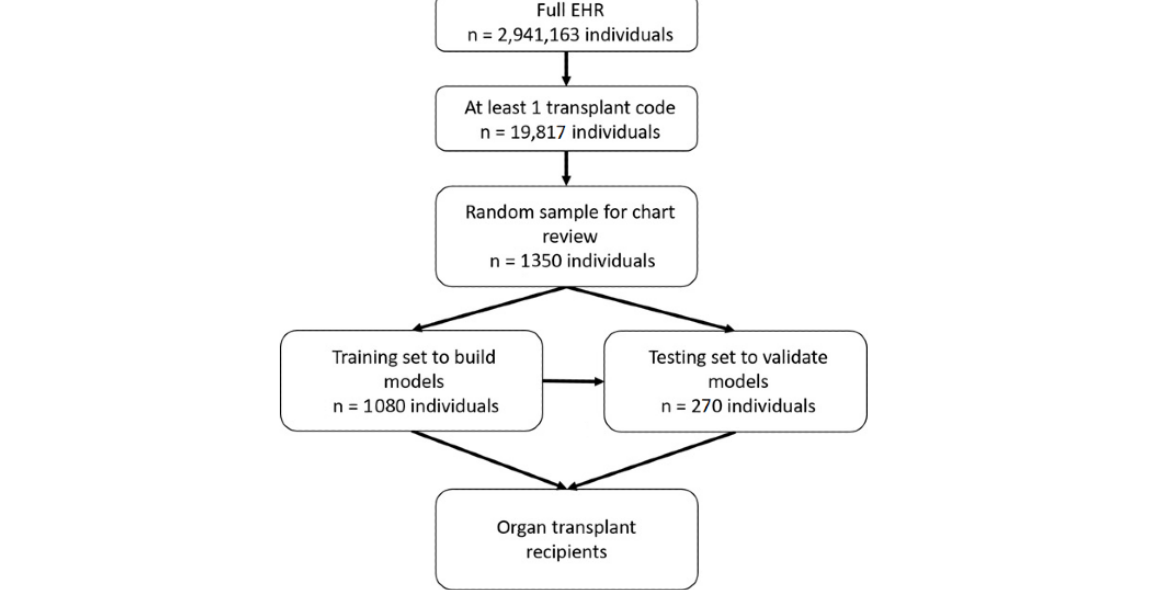
Figure 1. Selection of patients. From the full electronic health record, we identified 19,817 individuals with at least one transplant code, and from these, we selected a random sample of 1350 individuals for chart review and model building. EHR: electronic health